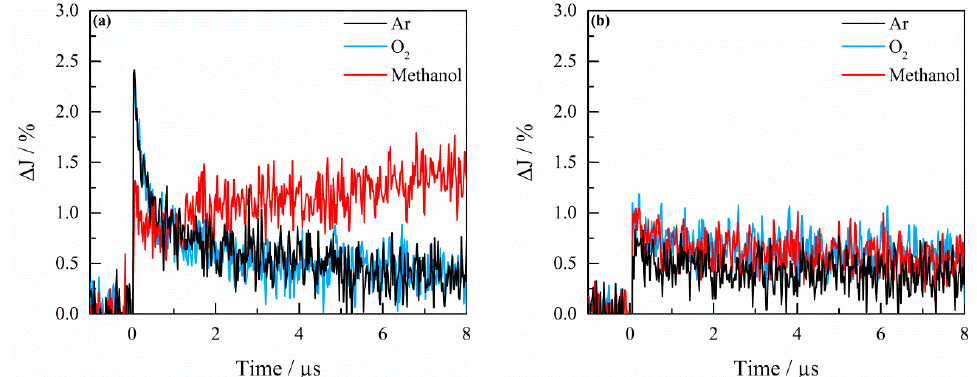
Figure 4. Transient absorption spectra of K-7000 measured 100 ns after excitation with a ( a ) 355 nm and ( b ) 455 nm laser in Ar (black), O 2 (blue), and methanol (red) atmospheres.